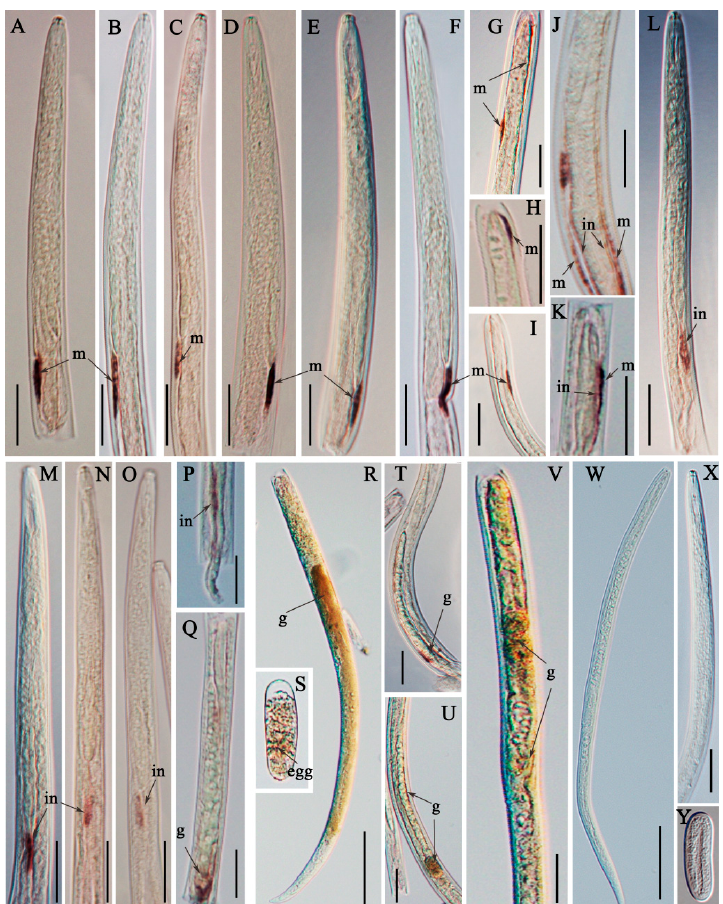
Figure 5. Tissue localization of Ar-far-1 mRNA in Aphelenchoides ritzemabosi using in situ hybridization. Ab-far-1 mRNA was present in the muscle layers near the end of the esophageal glands ( A – F ), as well as in the muscle layers of other parts of the body ( G – K ), intestines ( J – P ), female genital systems ( Q – R and T – V ) and eggs ( S ). No signal was observed in the nematode sections hybridized with a sense Ar-far-1 DIG-labeled RNA probe ( W – Y ). m: muscle layer; in: intestine; g: female genital system. Scale: A–Q, T–V and X 1 bar = 20 µ m; R and W 1bar = 50 µ m. Int. J. Mol. Sci. 2019 , 20 , x FOR PEER REVIEW